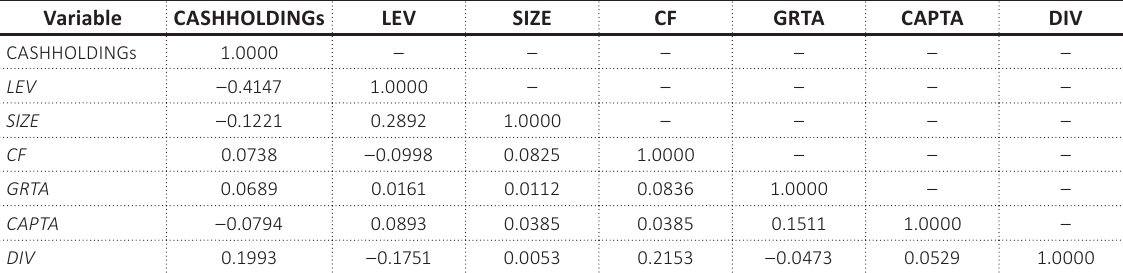
Table 2. Pair correlations of firm variables in the whole sample